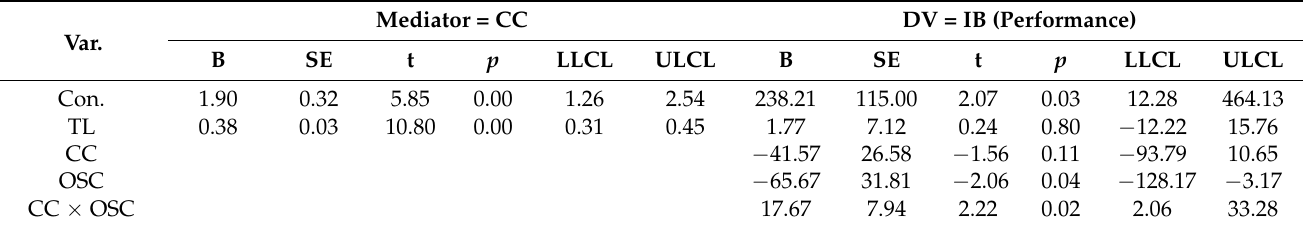
Figure 2. Interaction effects of support for creativity on innovative behavior (self-reported).